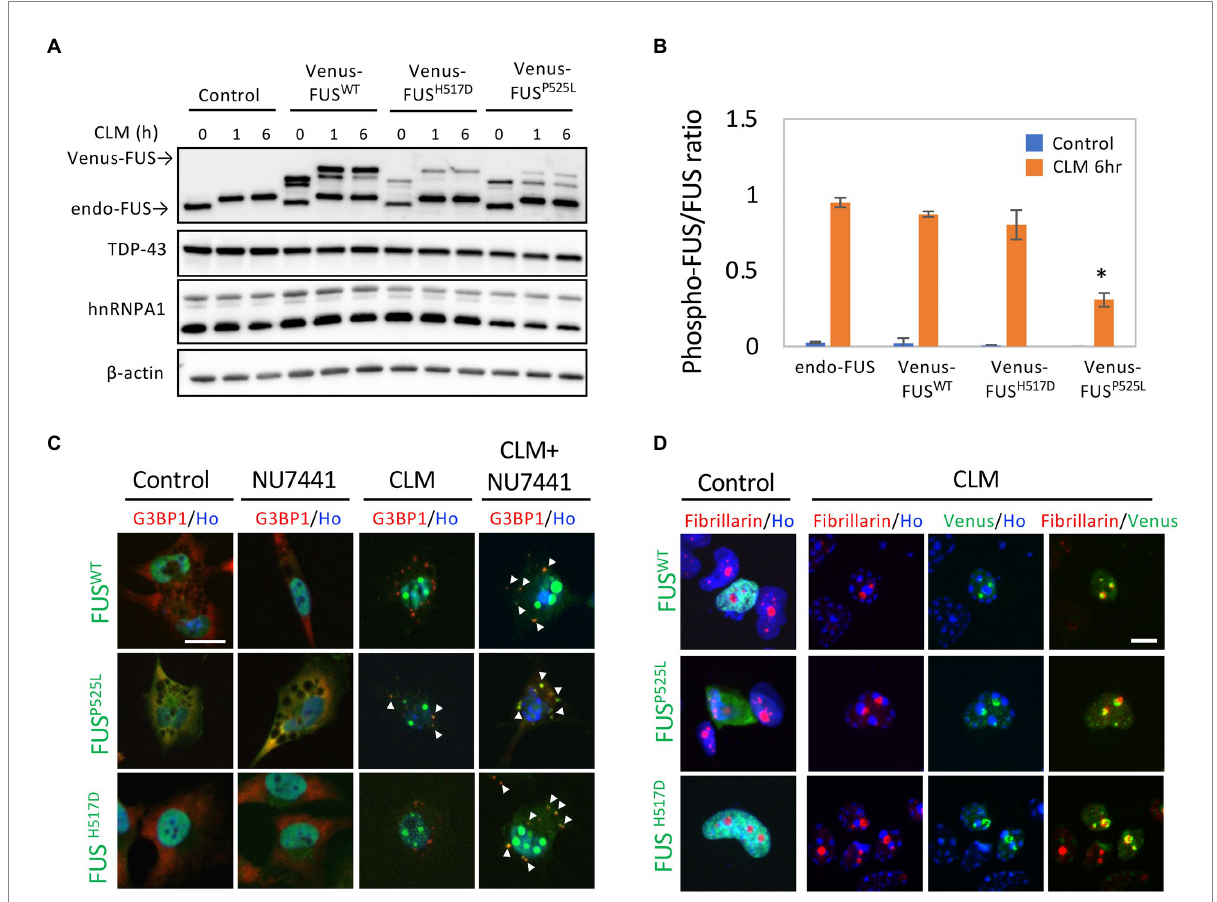
FIGURE 1 Subcellular localization of Venus-tagged FUS WT (Venus-FUS WT ) and mutated FUS proteins in living cells. (A) U251 MG (KO) cells overexpressing Venus-FUS WT , Venus-FUS H517D, and Venus-FUS P525L were generated, and Western blotting with an anti-FUS antibody was performed to confirm the expression of Venus-tagged FUS. Cells were treated with 100 nM calicheamicin (CLM) for 1 and 6 h. An anti-”TDP-43/hnRNPA1/ β -actin” antibodies were used as a control. (B) Quantification of ratio between phosphorylated FUS associated with band shift and normal molecular weight FUS band in endogenous and Venus-FUS WT , Venus-FUS H517D and Venus FUS P525L at the normal and CLM 6 h treatment with the Image J. The migration of Venus-FUS P525L protein shows significantly lower compared to other FUS variants by CLM stimulation. Asterisk indicates significant change from three independent experiments ( t -test p < 0.001). (C) The subcellular distribution of Venus-FUS WT , Venus-FUS H517D, and Venus-FUS P525L (Green) co- stained with G3BP1 (Red), a marker for SGs and Hoechst (Blue), a marker for nuclei was observed in cells by fluorescence microscopy. Cells were treated with the DNA-PK inhibitor NU7441 (1 μ M) for 3 h and were then treated with 100 nM CLM or DMSO (control) for 6 h in the presence of 1 μ M NU7441 or DMSO (control). Arrowheads indicate G3BP1 positive cytosolic SGs with Venus-FUS WT or Venus-FUS mutant proteins. Scale bar: 20 μ m. (D) The Venus-FUS WT , Venus-FUS H517D and Venus-FUS P525L protein were colocalized with the nucleolar marker fibrillarin in a CLM-dependent manner by CLM stimulation for 6 h. Scale bar: 10 μ